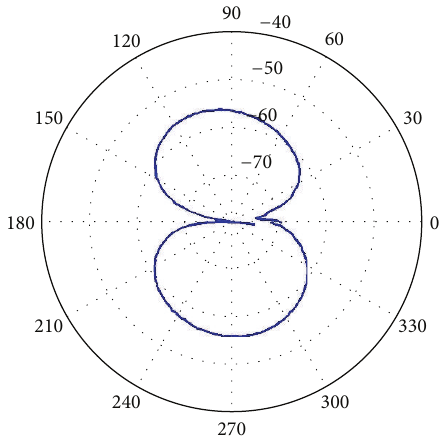
Figure 13: Radiation pattern graphic (measurement).